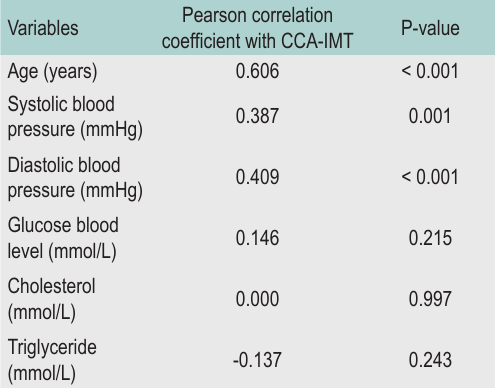
TABLE 2. Correlation coef fi cient between CCA-IMT values and quanti fi ed variables of the study Variables